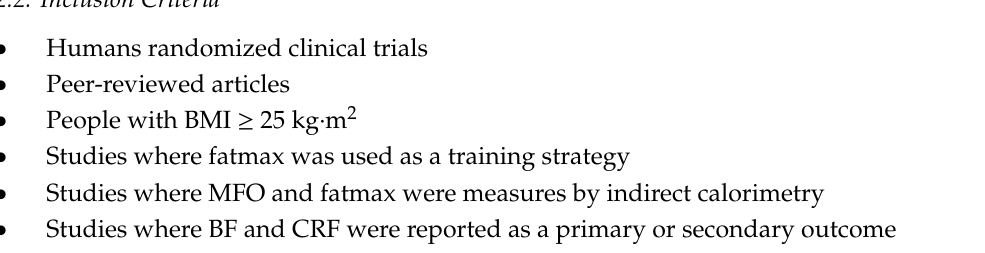
Figure 1. Flow chart of selected articles.